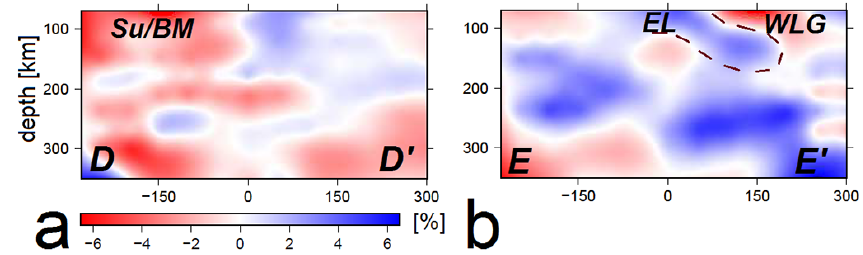
Figure 10. P wave velocity perturbations in vertical slices DD (cid:48) and EE (cid:48) transverse to the main transect (see Fig. 9a). (a) Low velocities are observed in the western part of the Bohemian Massif (BM) and the Sudetes Mountains (Su) from 70km. (b) Dashed line indicates a possibly resolved paleosubduction zone under Lithuania between the WLG and the